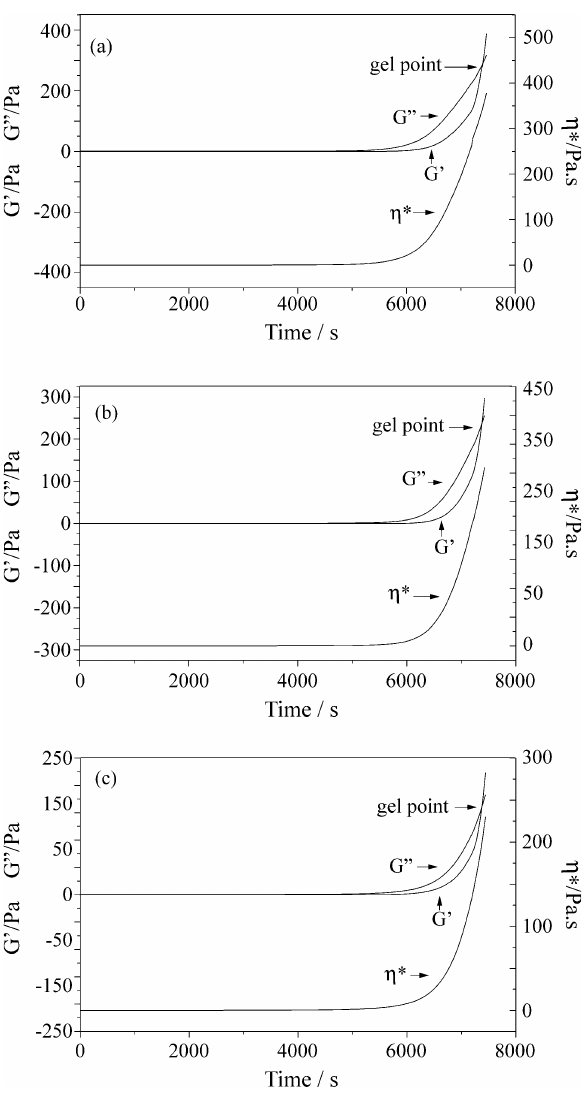
Figure 1. Isothermal rheograms at 100 °C: a) resol resin C; b) novolac resin A and c) novolac resin B.